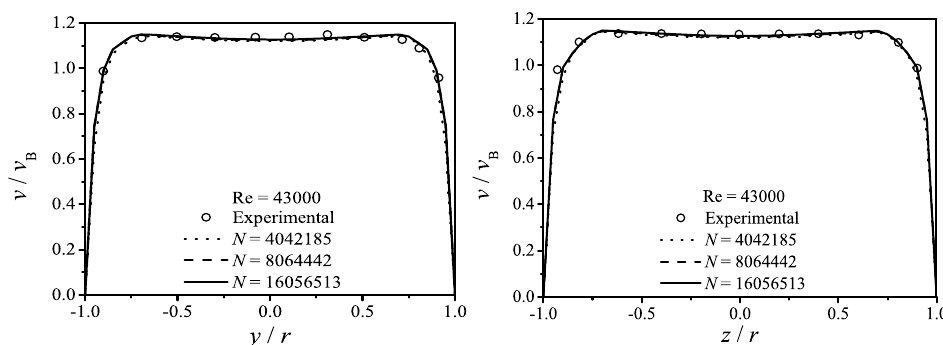
Figure 7. Comparison of the numerical normalized horizontal ( left ) and vertical ( right ) streamwise velocity profiles with the experimental measurements at S 2 = 0.58 D upstream of the bend inlet for Re = 43,000 and N = 4,042,185, 8,064,442 and 16,056,513 particles.